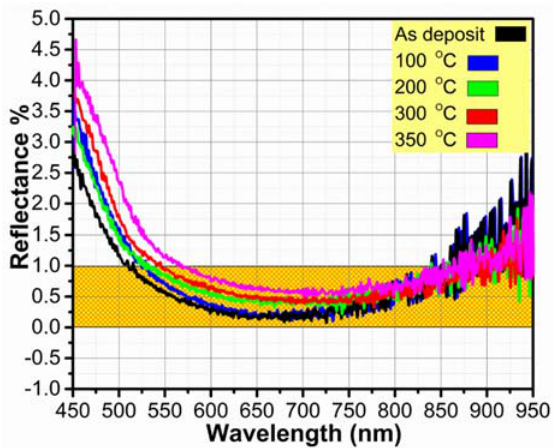
Figure 8. AR efficiency of as ‐ deposited and annealed nanozigzag SiO 2 AR coating at 100, 200, 300 and 350